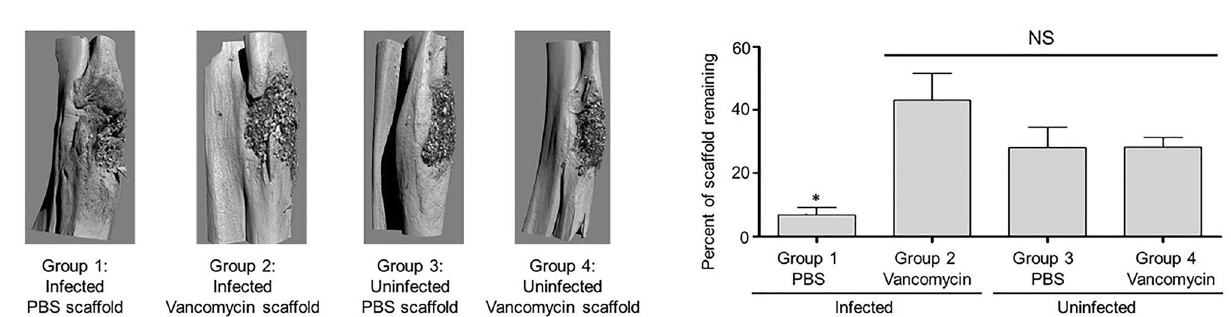
Figure 7. Radiographs from representative rabbits in each experimental group treated with the S1/100 scaffold formulation. Representative X-rays are shown from infected and uninfected rabbits exposed to the S1 scaffold saturated with PBS or 100 mg/mL vancomycin as indicated to the left. After 84 days, rabbits were humanely euthanized and the surgical limb harvested and frozen. Upon removal from the freezer, the surgical site was exposed and swabs taken from the surrounding soft tissues. The bone and its associated scaffold were then imaged by µCT before being homogenized and plated on tryptic soy agar to recover viable bacteria. The collective results observed with soft tissue samples and the bone/scaffold are shown to the right.